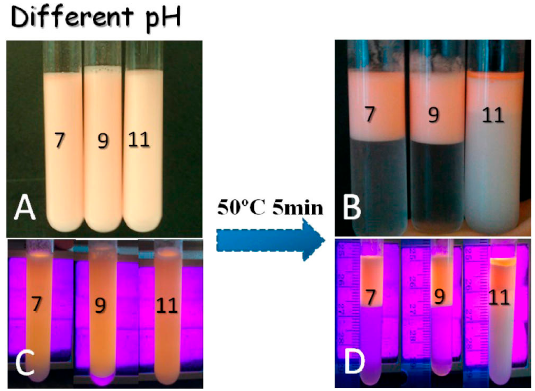
Figure 9. Photographs of toluene-water emulsions stabilized by PDMAEMA-g-CNC at different pH: without UV ( A ); with UV light ( C ); Photographs of emulsions taken after equilibration in a water bath for 5 min (without UV ( B ) and with UV light ( D )). Reprinted with permission from [95]. Copyright 2014, American Chemical Society.